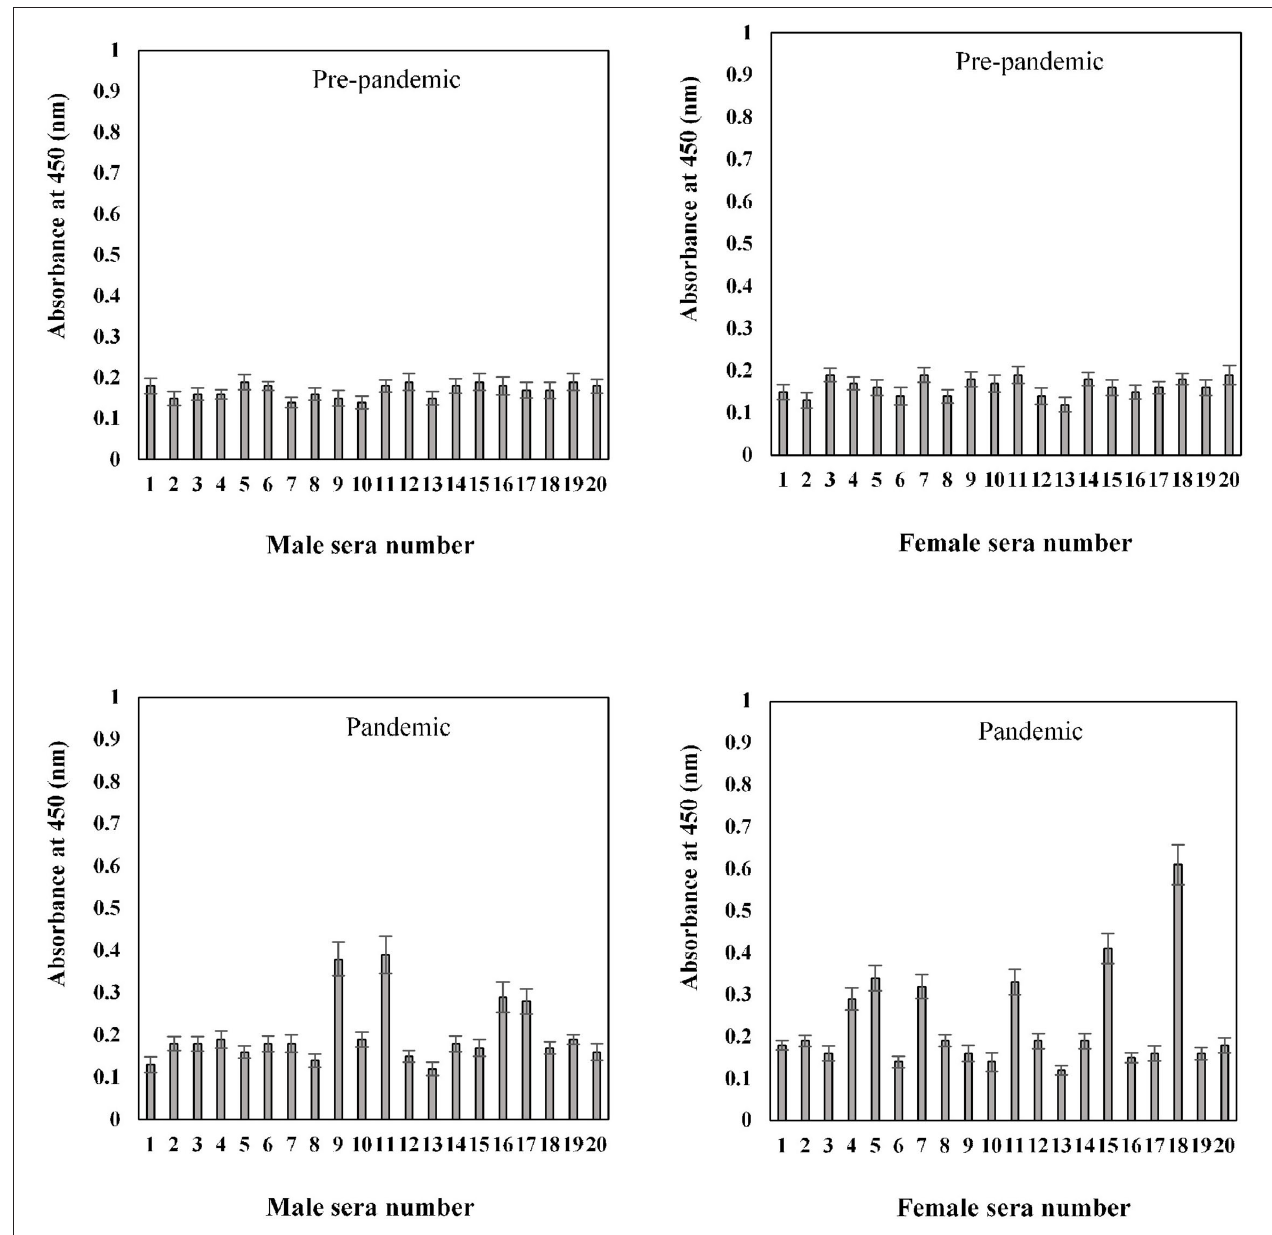
FIGURE 9 | Indirect binding ELISA from samples collected pre-pandemic and during the pandemic from men and women aged > 60 years. ELISA plates were coated with an antigen concentration of 2 µ g/ml. Each sample was run in triplicate under similar